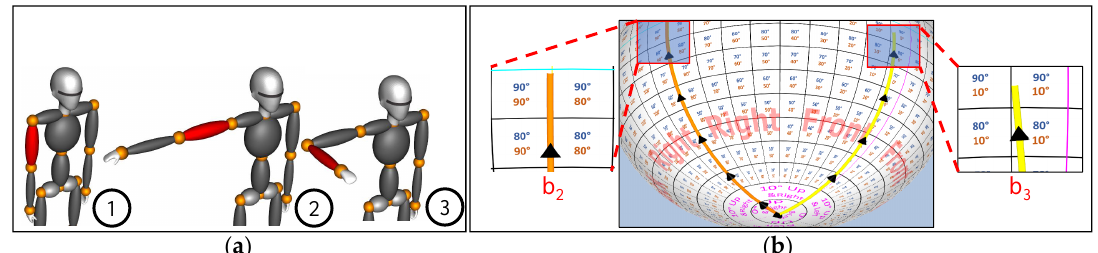
Figure 4. Upper arm has a 90 ◦ swing toward the right of the body and, the lower arm has a 90 ◦ swing in front of the upper arm: ( a ) A combined swing movement of parent–child (upper right arm–lower right arm) on the avatar. ( b ) Visualization of the combined swing movement on a